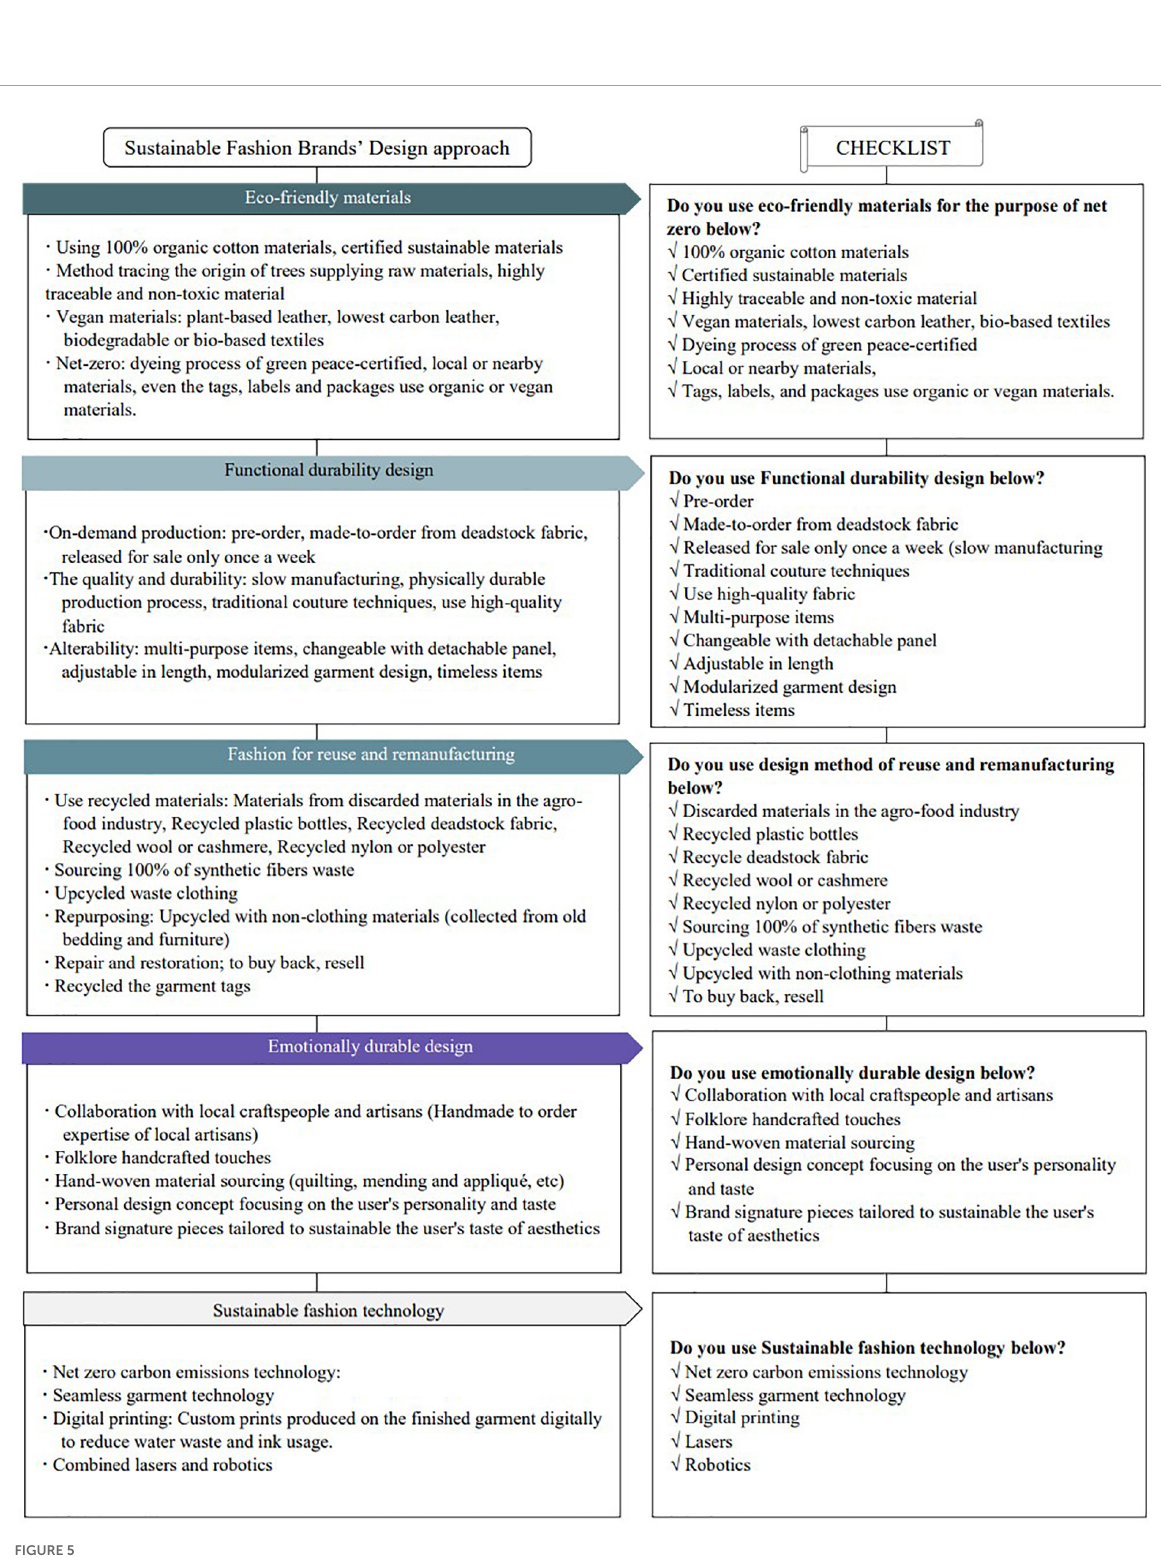
FIGURE5 Representation methods by sustainable fashion brand (SFB) design approach